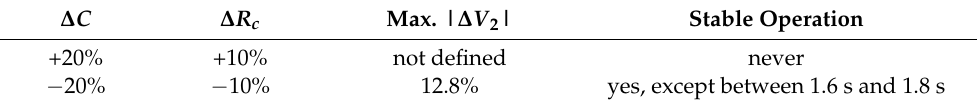
Table 11. Results of robustness analysis against variations of C and R c in Scenario #3.